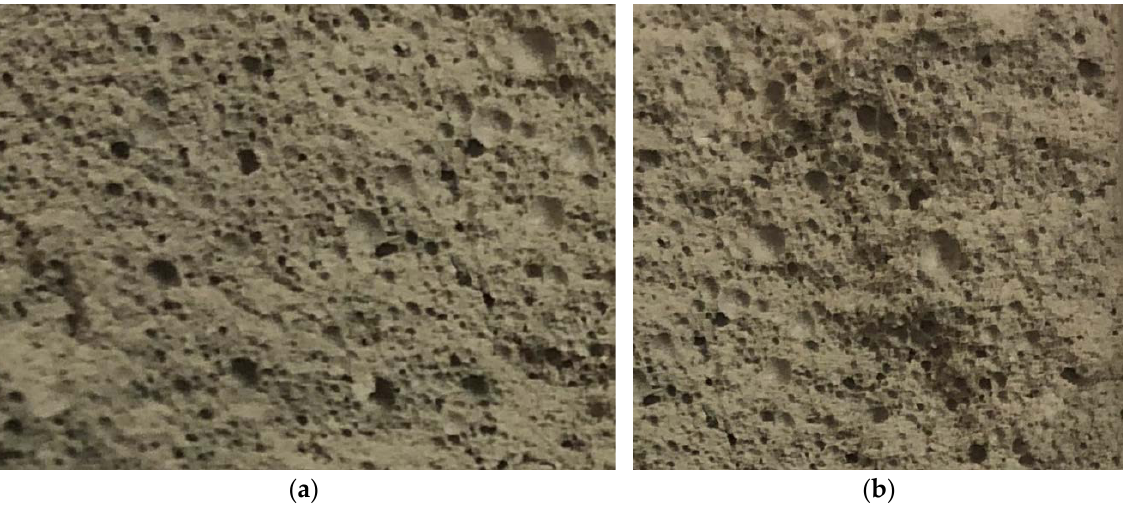
Figure 14. Pore macrostructure (with a magnification of 5 times): ( a ) control sample; ( b ) a sample of fiber-foam concrete using nanomodified microsilica and dispersion reinforced with polypropylene fiber.